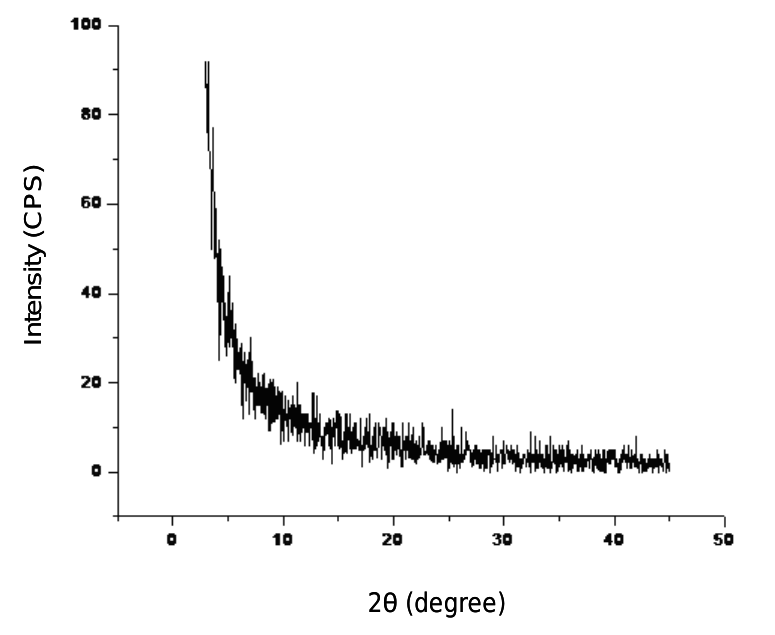
Figure 2. Atomic Force Microscopic Image of Carbon Substrate.